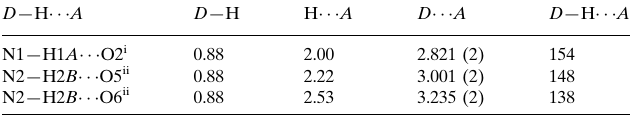
Hydrogen-bond geometry (A˚ , (cid:2)